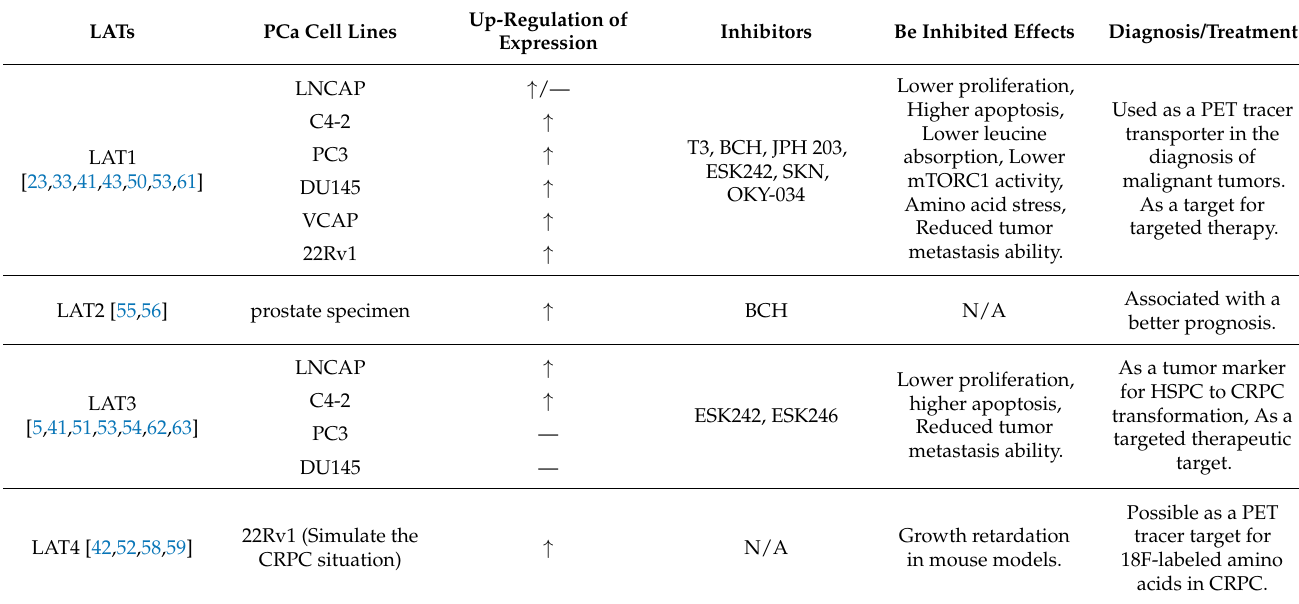
Table 1. The current relationship between LATs and prostate cancer. (Symbol ‘—’ represents that this cell line does not express the corresponding LATs according to the citation